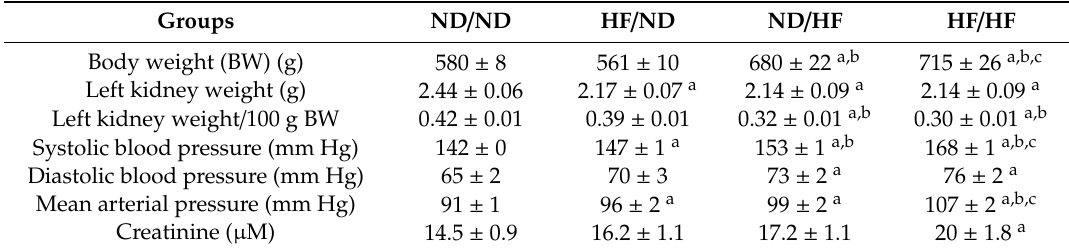
Table 1. Measures of morphological values, blood pressure, and renal function in 16-week-old male offspring exposed to high-fat diet (HF). Groups